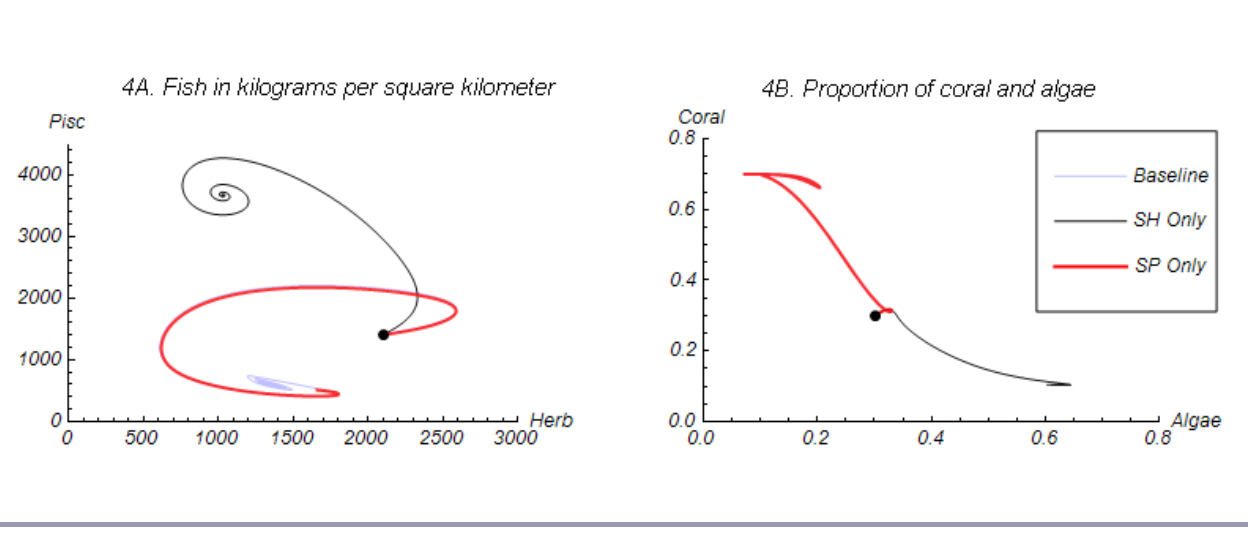
Fig. 4 . Simulation results with harvest by one type of fisher for fish (4A) and for coral and algae (4B). The dots represent initial